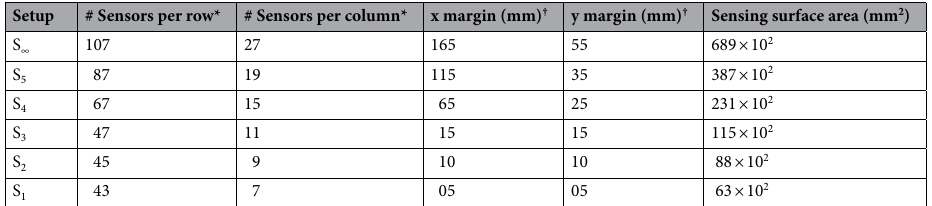
Table 1. Sensor planes size and number of sensors. *The number of sensors per row (x axis) and per column (y axis) is reported. † The x margin refers to the minimum distance between the edge of the sensor surface and the centre of the external magnet along the x direction (i.e., when the maximum L inter-MM of 25 mm is considered); the y margin represents the distance between the edge of the sensor surface and the moving magnet (i.e., MM 5 ) in correspondence of its maximum stroke of 10 mm .